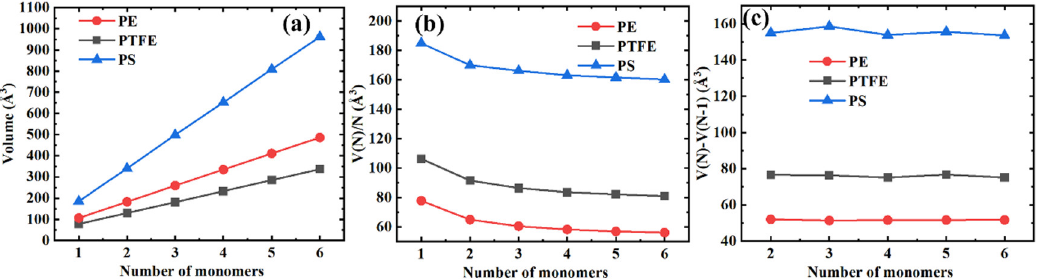
Figure 5. Different volume representations for three typical polymer materials. ( a ) The volume as a function of the number of monomers; ( b ) The volume per monomer unit as a function of the number of monomers; ( c ) Differences in the volume between the consecutive polymer chains.